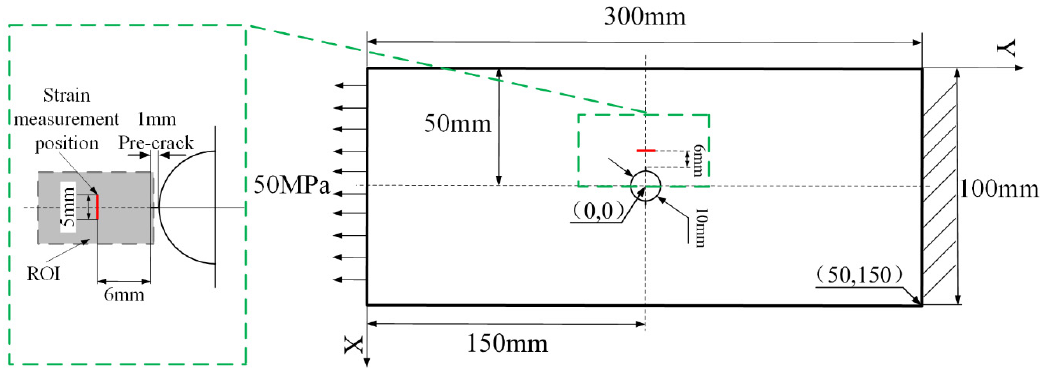
Figure 2. The schematic diagram of the geometric dimensions of the aluminum specimen.